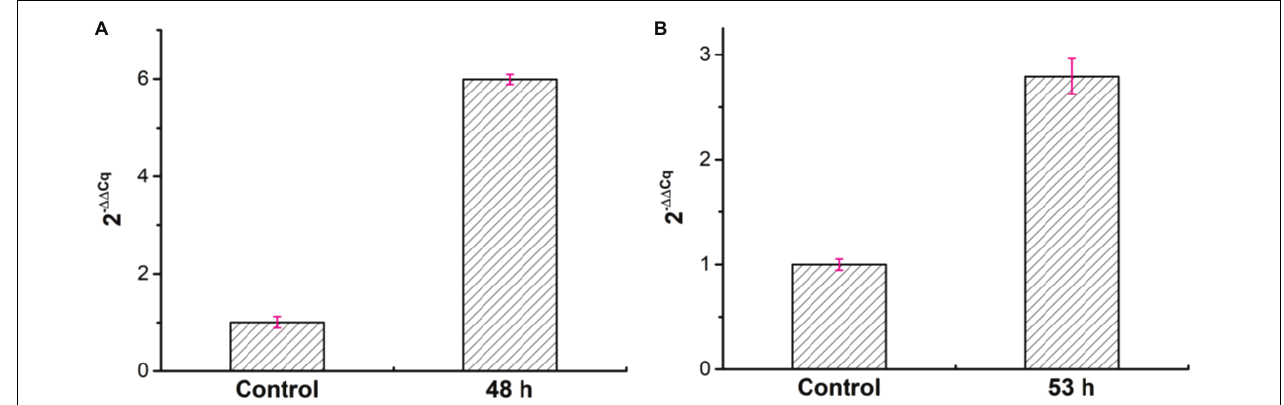
FIGURE 8 | Relative expression levels of welR at 48 h (A) and 53 h (B) by using the 2 − (cid:49)(cid:49) Cq calculation method.